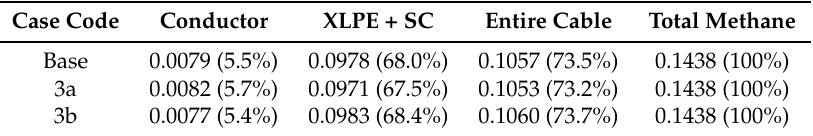
Table 8. Amount of CH 4 (mol/m) present in each cable component at the cable take-up point.